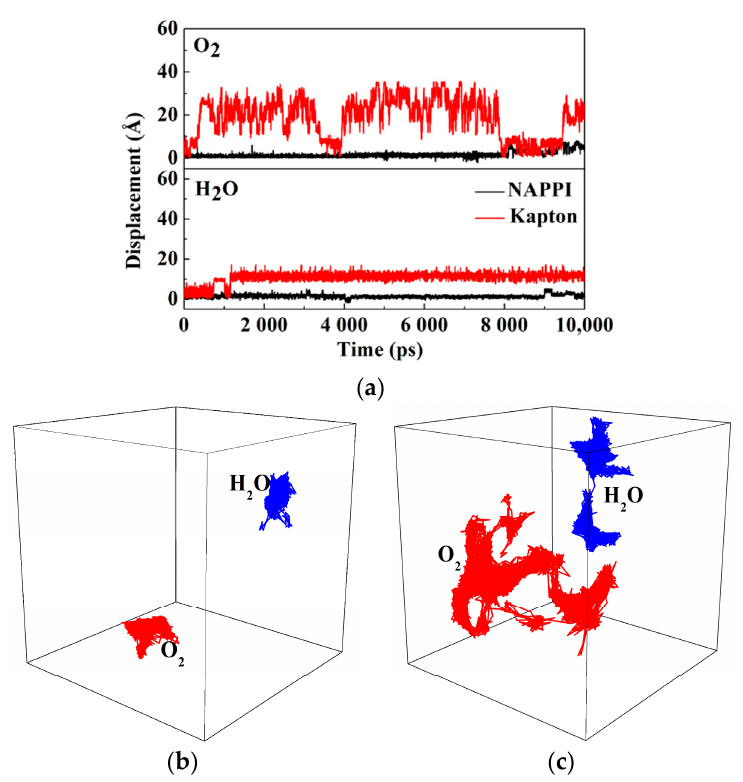
Figure 15. ( a ) Displacement and trajectories of H 2 O and O 2 in ( b ) NAPPI and ( c ) Kapton.